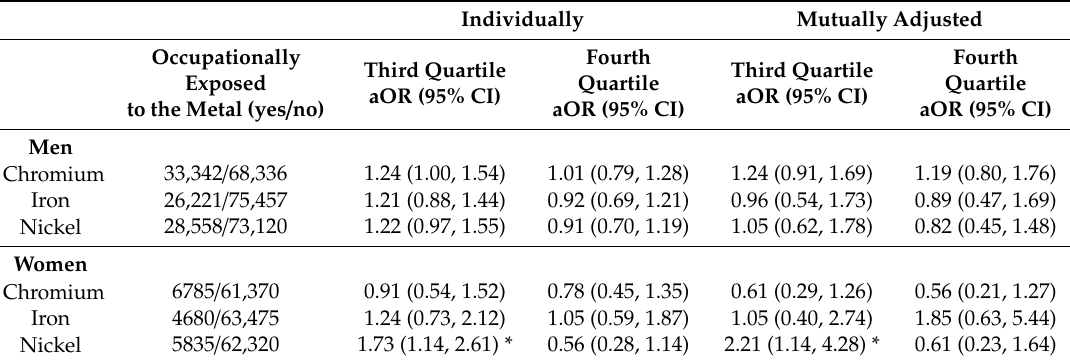
Table 3. Odds of ALS by 5-year lagged quartile exposures, Denmark,